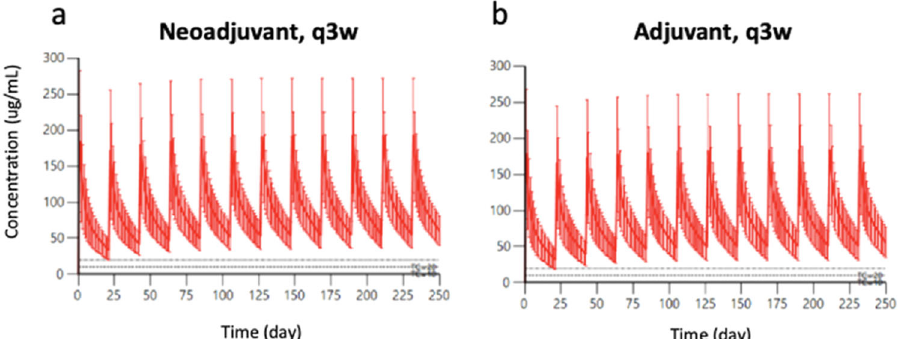
Fig. 1 Simulated concentration-time pro fi les for all HER2-positive early breast cancer patients receiving trastuzumab every 3 weeks. Simulated concentration-time pro fi les for patients receiving trastuzumab on a q3w schedule in the a neoadjuvant or b adjuvant. The solid red line indicates median concentration, and the red shaded region represents the 95% CI. Upper dashed line represents concentration = 20 µg/mL. Lower dashed line represents target concentration = 10